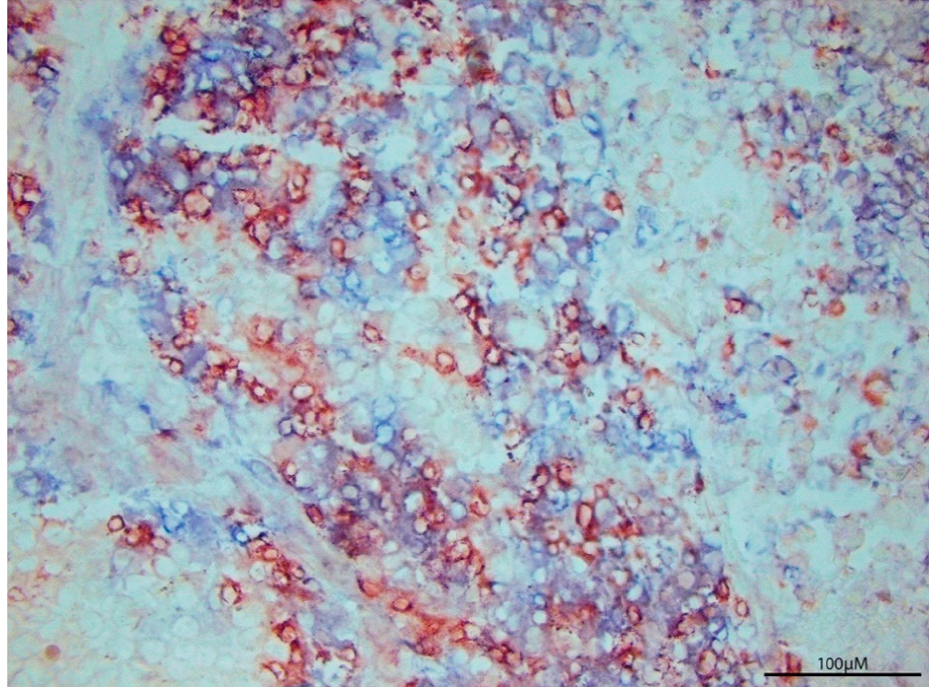
Figure 1. T cell Infiltration per se does not define tumor regression. P607 tumor tissue was surgically resected from a metastatic melanoma patient, revealing abundant T cell infiltration by immunoperoxidase labeled anti-CD8 (red) and alkaline phosphatase labeled anti-CD3 staining (blue). Cytokine analysis of tumor homogenates can reveal the prevailing immune response to better understand tumor expansion despite heavy T cell presence.